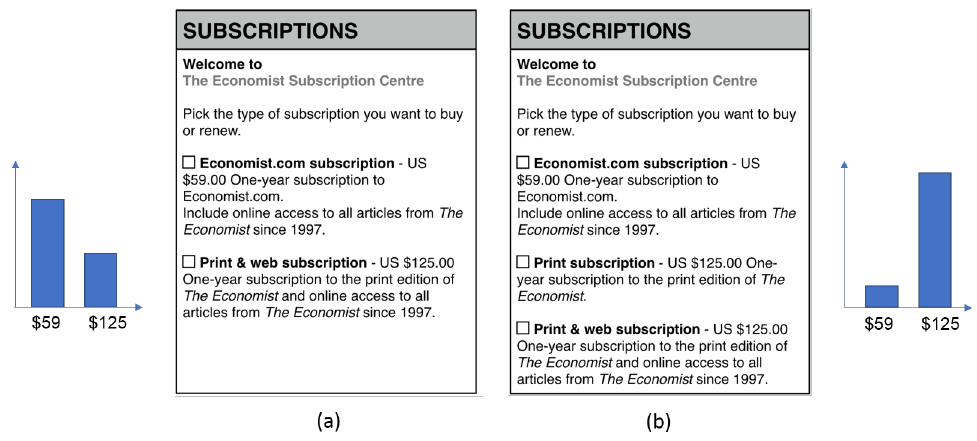
Figure 1. Two subscription pages of the Economist magazine adopted from [1]: ( a ) a subscription page with two common options; ( b ) a subscription page with the two common options and a